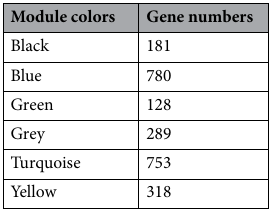
Table 2. Identified gene modules and their gene numbers.